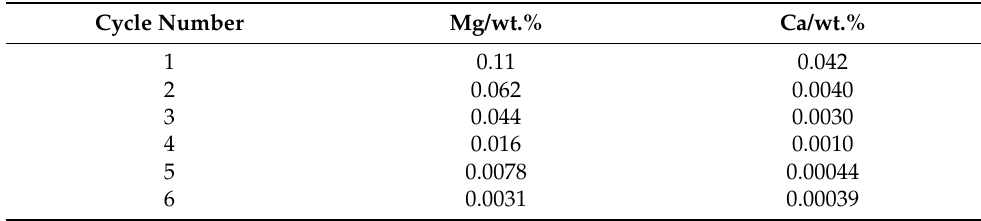
Figure 5. ( A ) The effect of H 2 O ratio on MnSO 4 • H 2 O yield during recrystallization; ( B ) The effect of cycles on MnSO 4 • H 2 O yield and Mg 2+ , Ca 2+ removal rate. Table 2. Residual content (wt.%) of Mg 2+ and Ca 2+ in MnSO 4 • H 2 O with different recrystallization